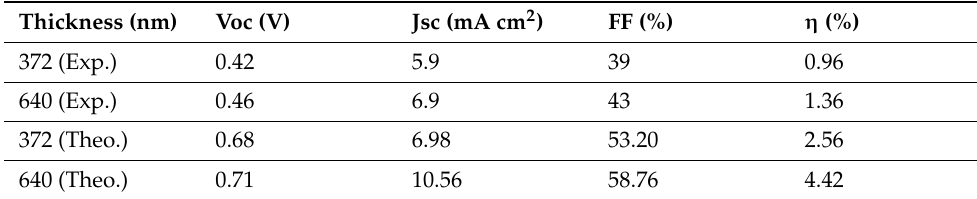
Figure 5. ( a ) I–V and ( b ) QE characteristics for two different thicknesses. Table 2. Comparison of experimental and theoretical results for two different thicknesses of active Sb 2 Se 3 layer.